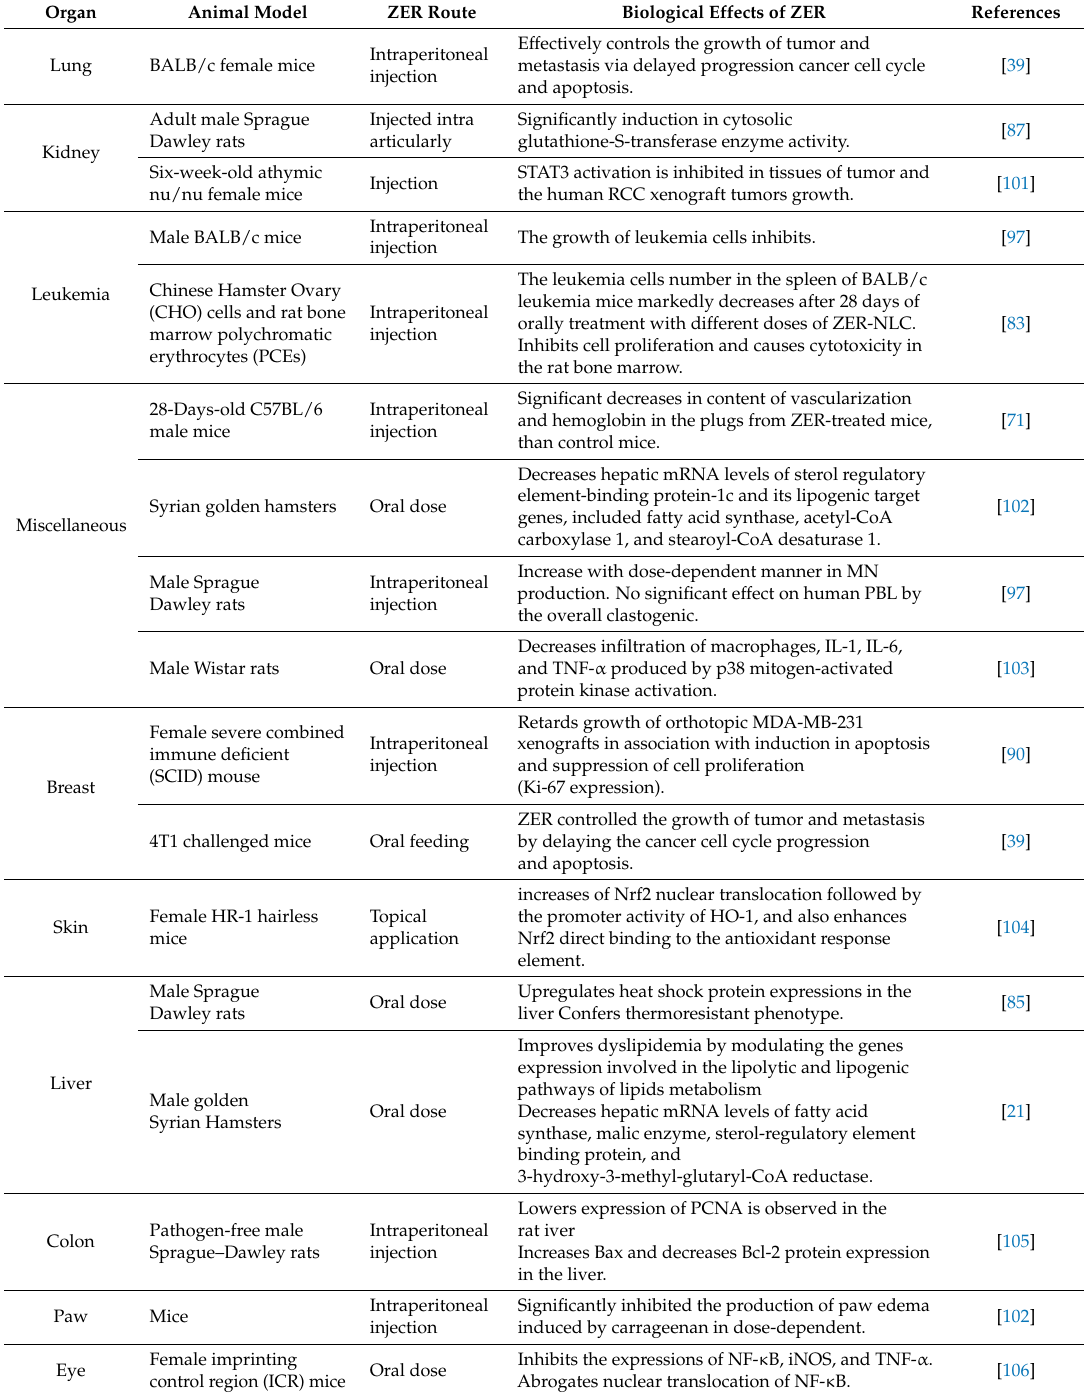
Table 2. In vivo biological effects of